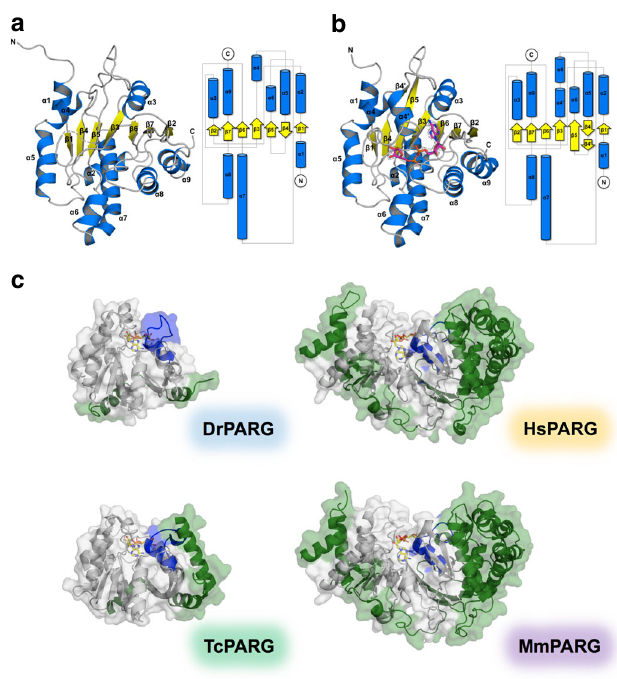
Fig. 1 Crystal structures of apo and ADP-ribose-bound forms of DrPARG. a , b Structure and topology diagram of a apo and b ADP-ribose-bound forms of DrPARG. Left, structures are presented by cartoon models with helices, strands, and loops colored blue, yellow, and gray, respectively. The region not well de fi ned in the electron density maps is omitted and shown as dashed lines. ADP-ribose is displayed in sticks with carbon in magenta, oxygen in red, nitrogen in blue, and phosphorous in orange. The 2 F o - F c difference map, contoured at 1 σ , was calculated at 1.97 Å resolution from a model with the ligand omitted. Right, topology diagrams with the same colors as for cartoon representations. c PARG structures in complex with ADP-ribose from Deinococcus radiodurans (DrPARG; PDB code 5ZDB), Thermomonospora curvata (TcPARG; PDB code 3SIG), Homo sapiens (HsPARG; PDB code 4B1H), and Mus musculus (MmPARG; PDB code 4NA0) are shown as cartoon models. α 4 ′ helix along with the catalytic loop of DrPARG and their corresponding regions of other PARGs are colored blue. The conserved macrodomain and the N- or C-terminal extension structures are colored gray and green, respectively. ADP-ribose molecules are shown as sticks with carbon, nitrogen, oxygen, and phosphorous colored yellow, blue, red and orange,